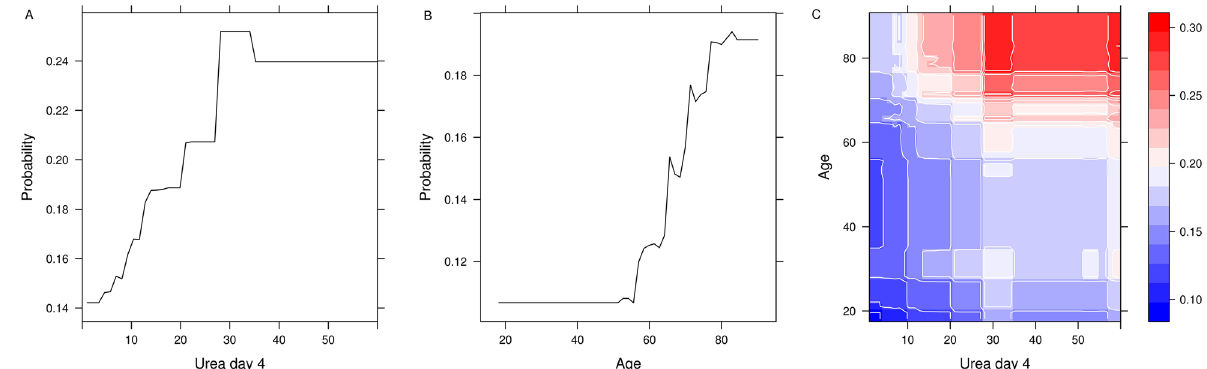
Figure 4. Partial dependence plots of urea at postoperative day 4 and age. Partial dependence plots of urea at postoperative day 4 against age. The vertical bar represents predicted risk (blue to red, low to